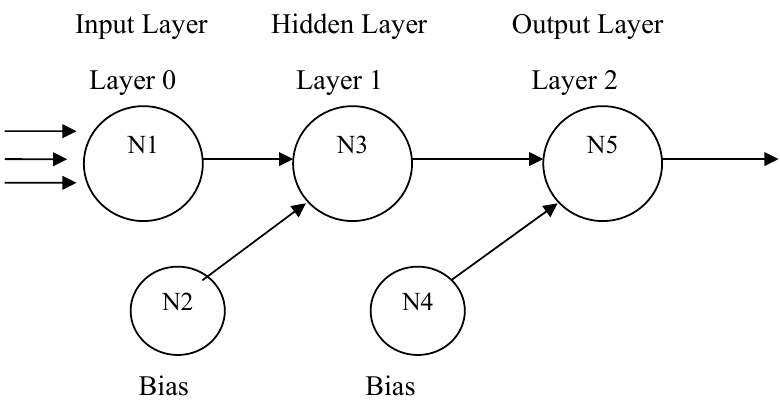
Fig. 1. The single hidden layer neural network used in this